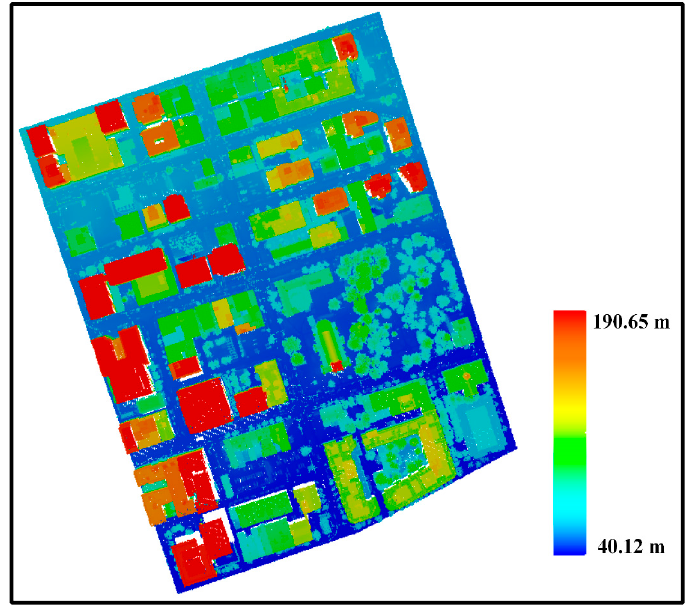
Figure 9. Raw point clouds of the Toronto dataset provided by International Society for Photogrammetry and Remote Sensing (ISPRS).